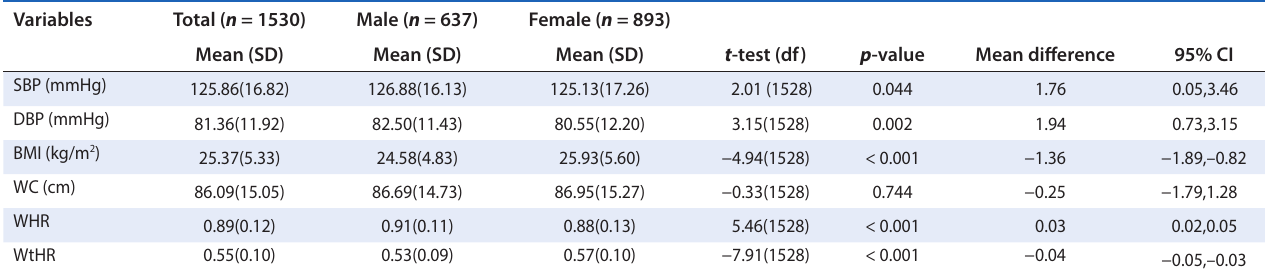
Table 2: Sex differences in study variables Variables